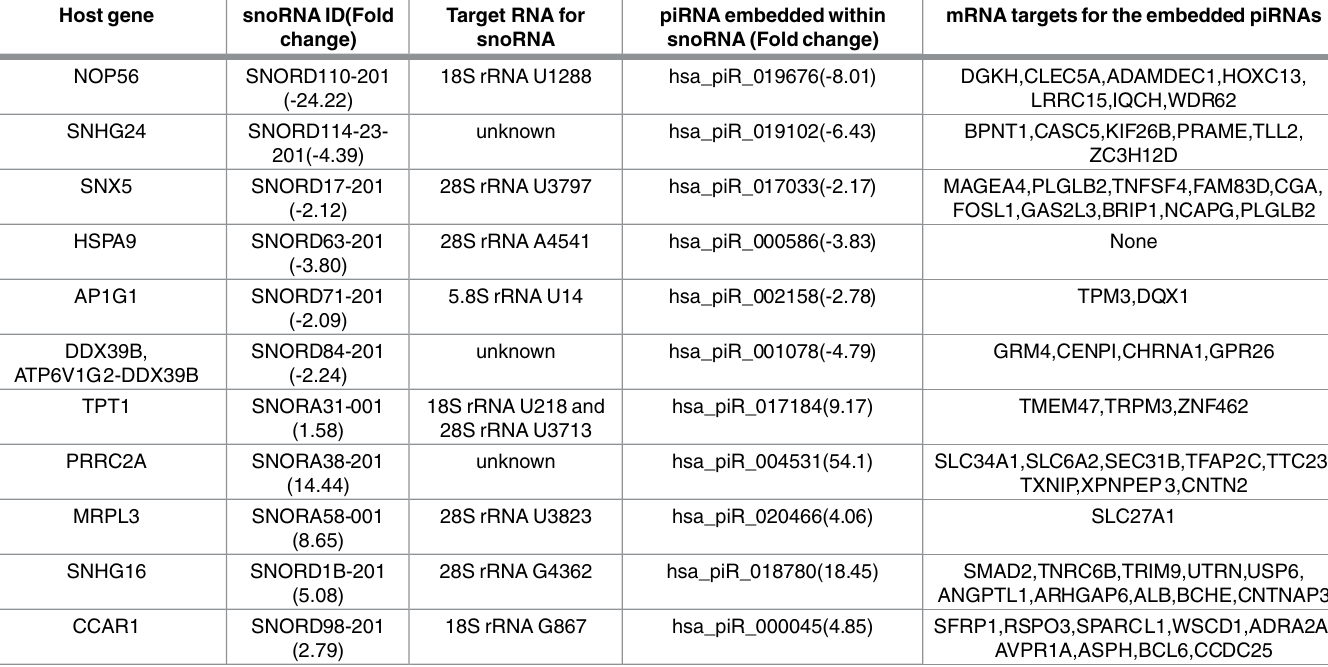
Table 2. snoRNA-piRNA pairs withsame directionof expression, fold change > 2.0 and FDR (cid:20) 0.05. Host